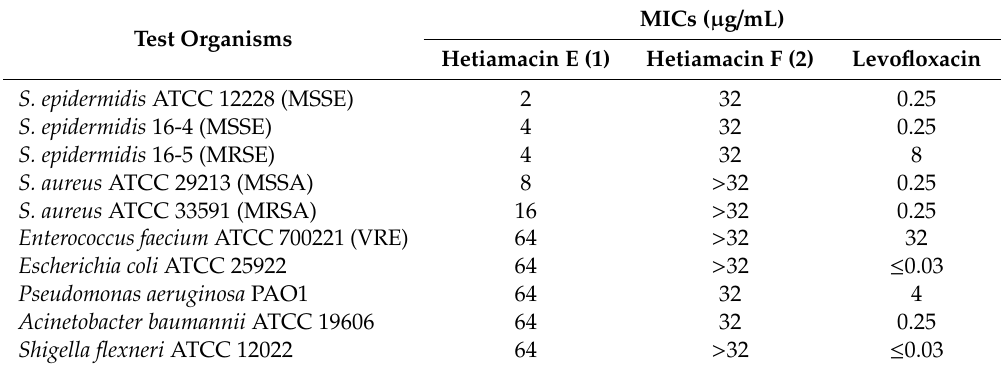
Table 2. Minimum inhibitory concentrations (MICs) of hetiamacin E ( 1 ) and hetiamacin F ( 2 ). Test